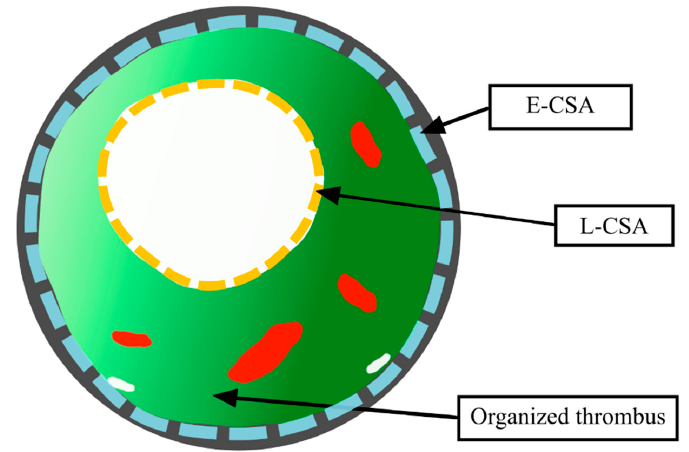
Figure 1. Schematic presentation of the pulmonary artery (PA) segment occupied by an organized thromboembolic lesion The external elastic membrane is depicted with the grey color. Dashed blue line enclosed by the external elastic membrane constituted the overall segment cross-sectional area (E-CSA in the text). The lumen of the stenosed PA segment (L-CSA in the text) is depicted by yellow dashed line.